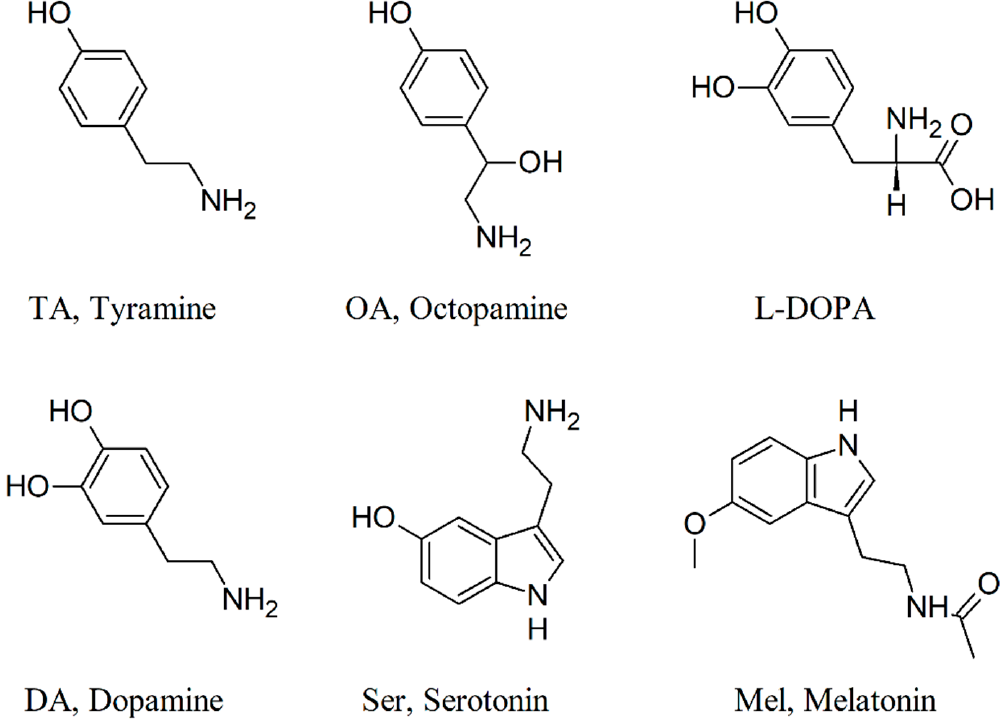
Figure 4. Chemical structure of the BAs analyzed in L. niger brain.